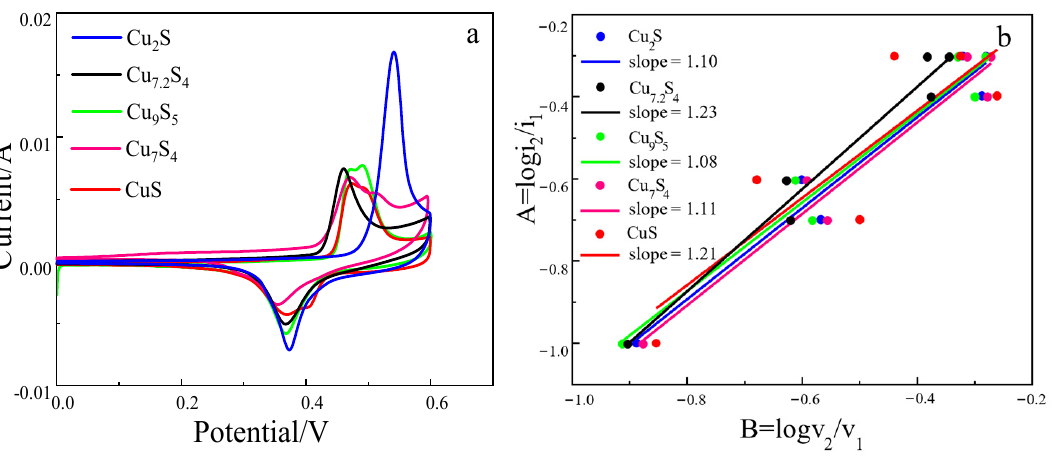
Figure 3. ( a ) is the CV curves of a CuS, Cu 7 S 4 , Cu 9 S 5 , Cu 7.2 S 4, and Cu 2 S at scanning rate of 5 mV/s; ( b ) is the capacitance contribution b of different copper sulfides.